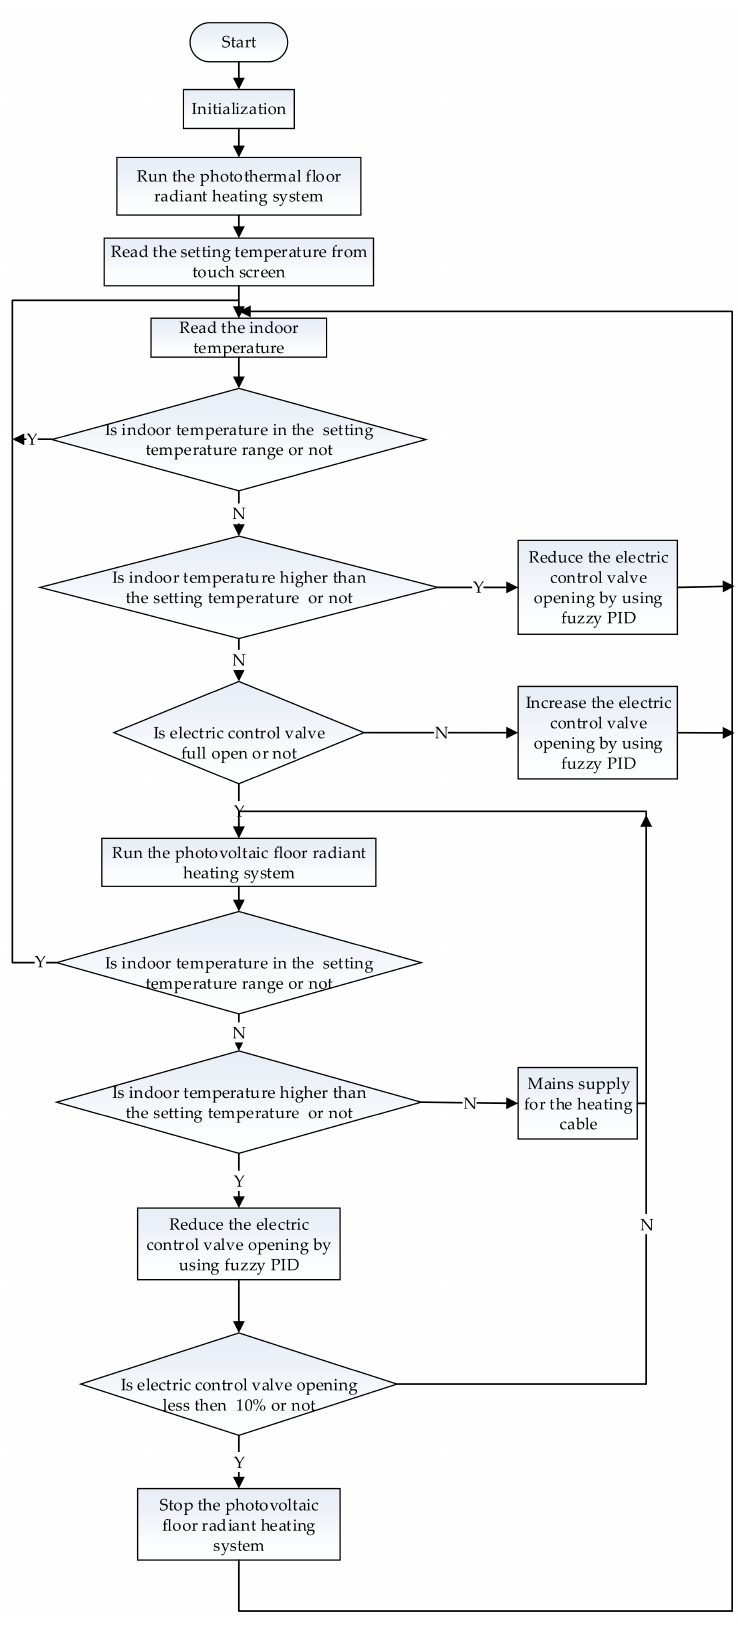
Figure 5. Flow process chart of the main